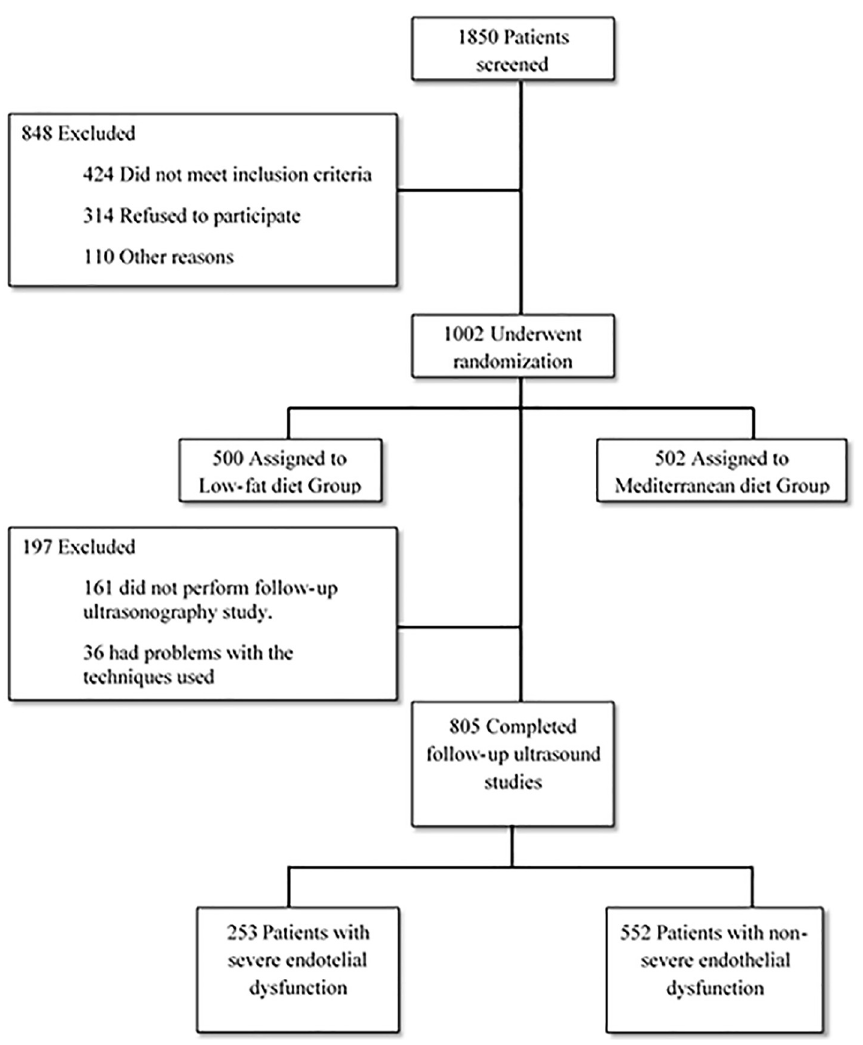
Fig 1. Screening and randomization flow-chart of the CORDIOPREV study and the ultrasound assessment of endothelial-dependent flow-mediated vasodilation of the brachial artery. CORDIOPREV, CORonary Diet Intervention with Olive oil and cardiovascular